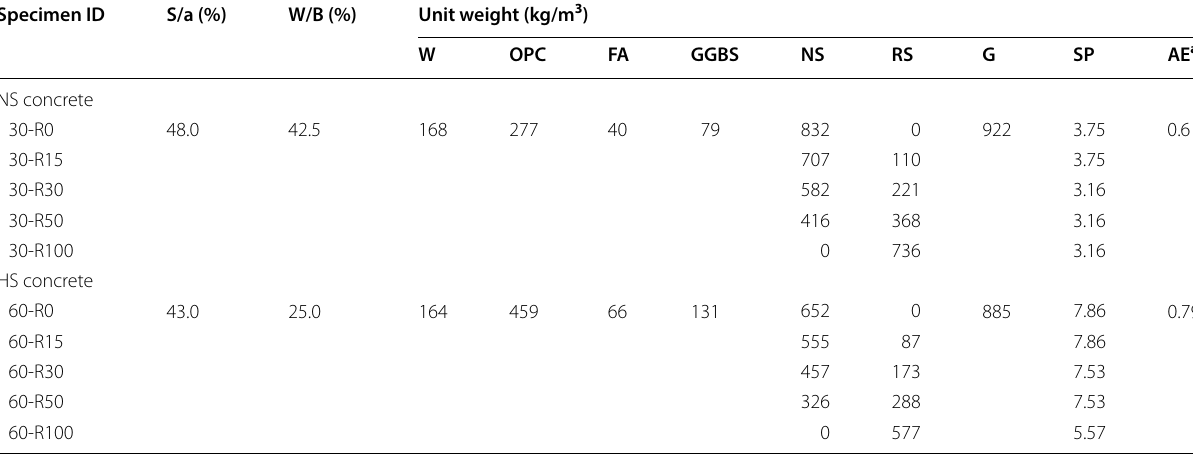
Table 3 Mixture proportions of NS and HS concrete.